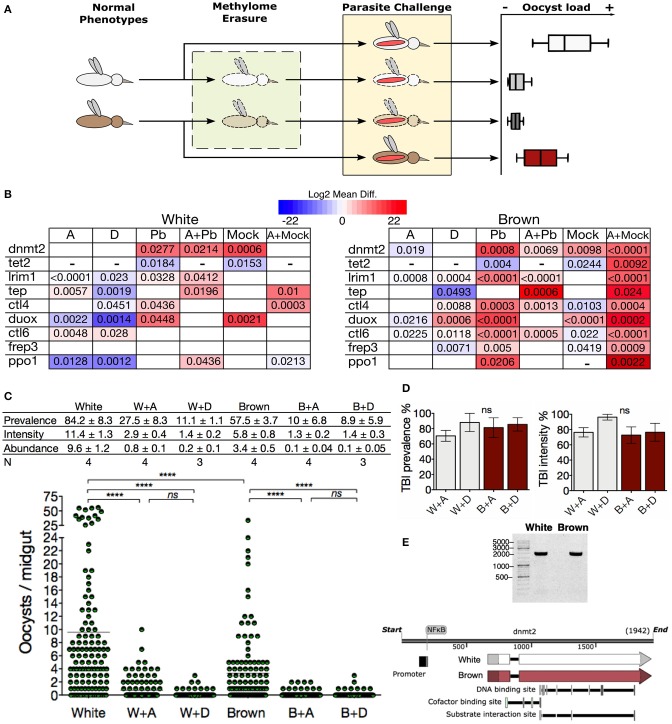
Inhibition of DNA methylation brings A. albimanus mosquitoes into a resistance condition against Plasmodium. (A) Depicts the followed methodology. mRNA samples were taken for each experimental group of mosquitoes (normal phenotypes, methylome erasure, and parasite challenge). (B) Midgut gene expression heat map of White and Brown mosquitoes after exposure to azacytidine (A), decitabine (D), and P. berghei-infected blood meal (Pb). Combination treatments included azacytidine plus infected blood meals (A+Pb) and azacytidine plus mock cultures (A+Mock). Color gradient represent mean difference (log2) between the basal expression and the treated condition. Only gene expressions with significant differences are shown. A blank box means that no statistically significant change was detected. A dash was placed when no transcript could be detected. Numbers inside the boxes are the P values calculated by two-tailed t test between each phenotype's control and the treated and/or fed groups. (C) Effect of methylation inhibition by azacytidine (A) and decitabine (D) on the infection parameters. Mean ± SEM, N = number of experiments with 30 mosquitoes each, analyzed by Kruskal-Wallis and Dunn's multiple comparisons test, ****P < 0.0001. (D) TBIs efficacy of the azacytidine (A) or decitabine (D) treatment in White (W) and Brown (B) mosquitoes. Graphs were made with data from (C). (E) Long PCR of dnmt2 for sequencing (Figure S7) and a schematic representation of the dnmt2 gene.